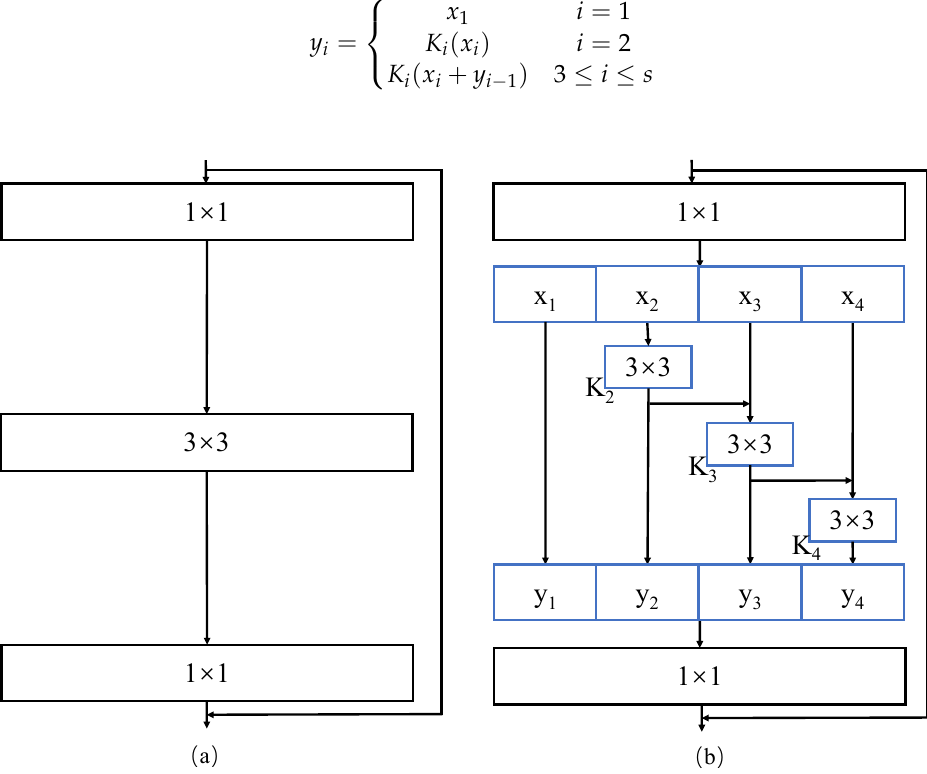
Figure 3. ResNet block and Res2Net block architecture. ( a ) ResNet block. ( b ) Res2Net block. x i ( i = 1,2,3,4 ) represents the split feature map subsets, K i ()( i = 2,3,4 ) denotes 3 × 3 convolution and y i ( i = 1,2,3,4 ) refers to the output of K i () . Each 3 × 3 convolution K i () has the potential to receive the information of all previous (cid:8) (cid:9) x j , j ≤ i feature map subsets, i.e., that from . Thanks to the 3 × 3 convolution, the receptive field of each feature split’s output x j is larger than that of x j . Then all splits are concatenated and 1 × 1 convolution is used to better fuse the information of different scales. The strategy of split and concatenation enables the module to process features with extraordinary efficiency. The output feature map contains different receptive fields, which are conducive to extracting multi-scale features. As a result, Res2Net can capture global and local features at a finer